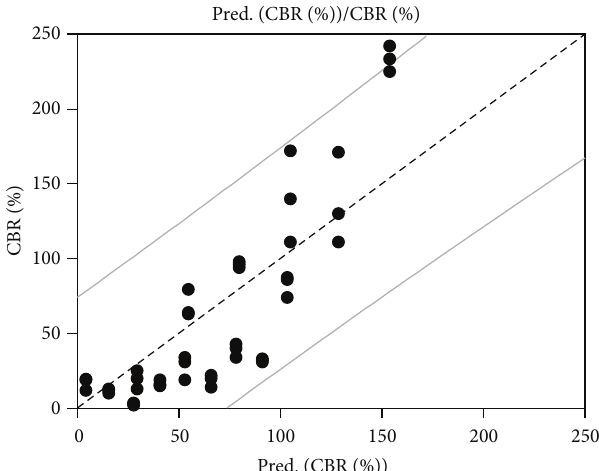
Figure 19: Measured and predicted CBR values derived from